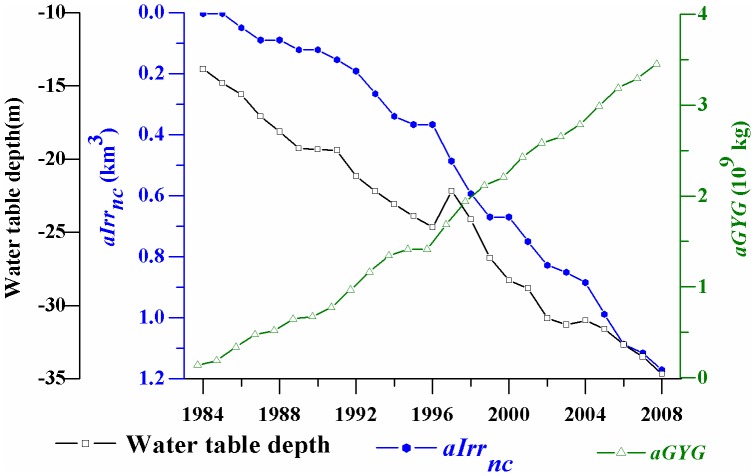
Accumulated net groundwater consumption (aIrrnc), grain yield gain (aGYG), and observed groundwater table depth change for Luancheng county (1984–2008).